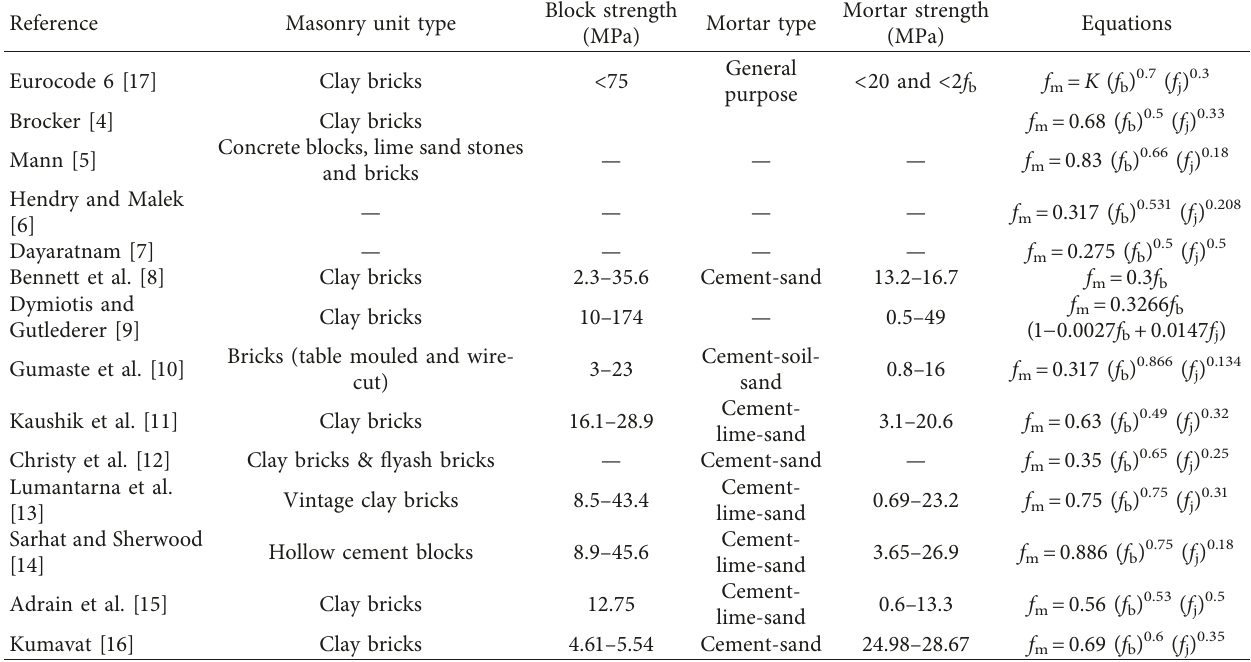
Table 1: Summary of the predicted equation for the estimation of masonry strength.